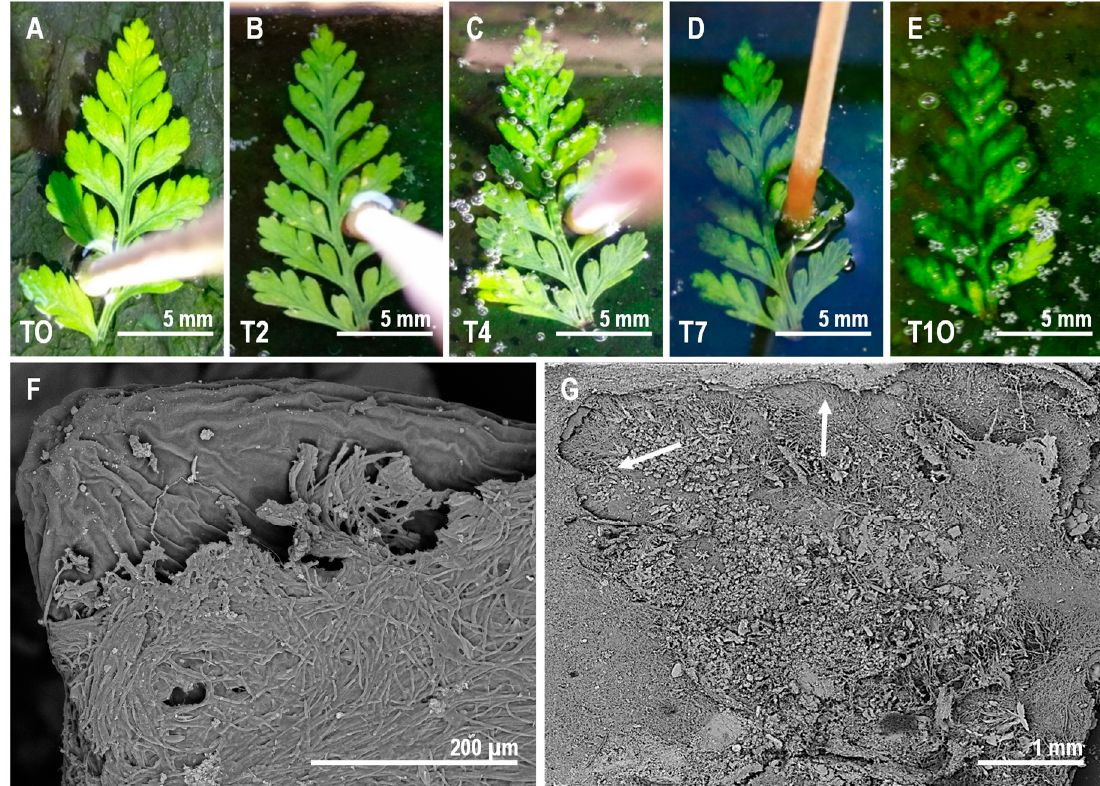
Figure 3. Sequence of coverage of the pinna by the microbial mat over the course of the experiment. ( A – E ) Gradual initial phase of coverage from day 0 (T0, A ) to day 10 (T10, E ). ( F ) SEM observations of the microbial veil covering the pinna. ( G ) Impression of the lower side of the fern pinna left on the surface of the mat after its removal at day 7. The shape of the fern in the mat is highlighted by two white arrows.